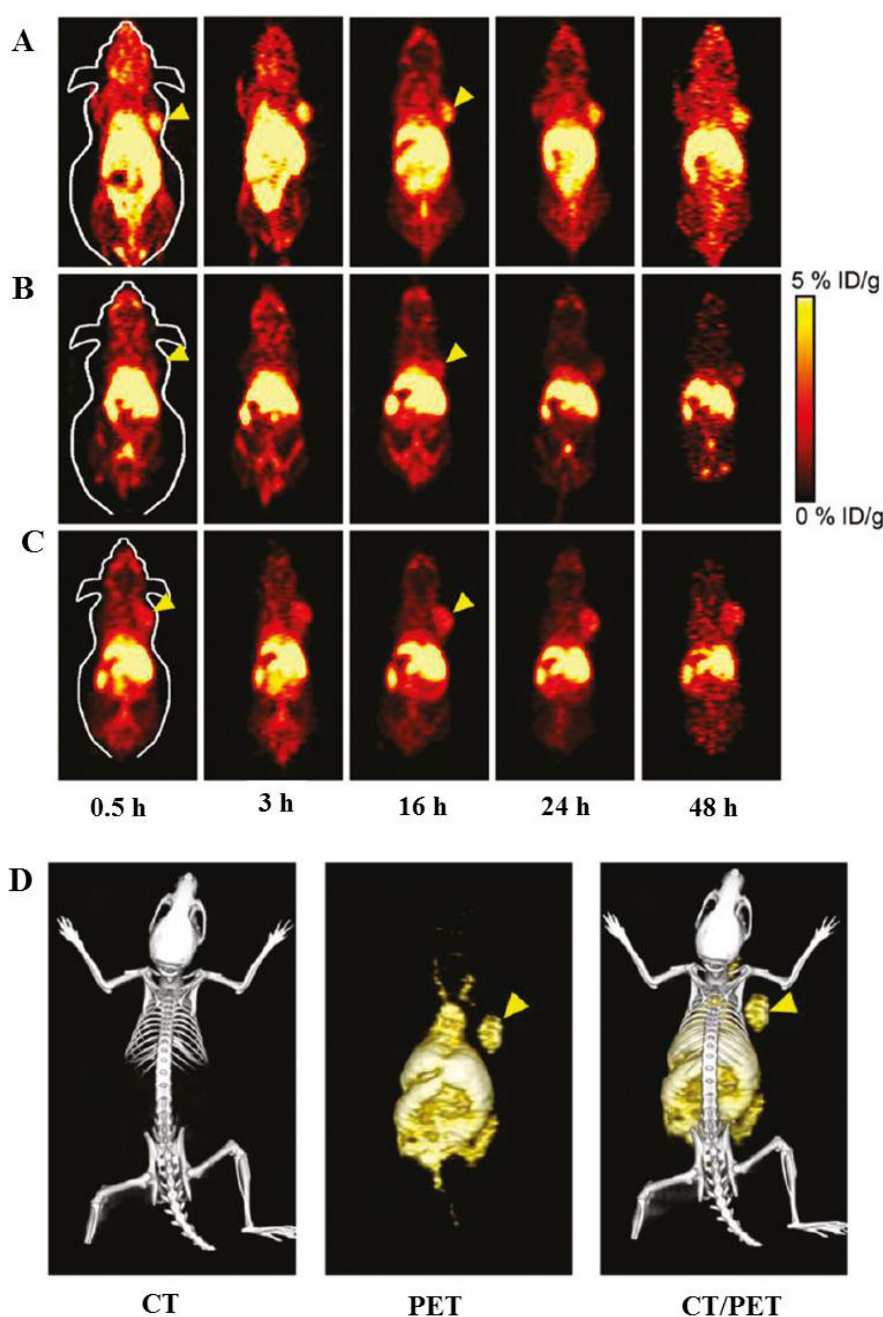
Figure 8. PET and CT in vivo 4T1 tumor containing mice images of GO labelled with 64 Cu isotope and tumor targeting TRC105 bioconjugate. ( A ) The post injected 64 Cu-NOTA-GO-TRC105 PET images with different time intervals from 0.5 h to 48 h. The arrows at the right corners of the